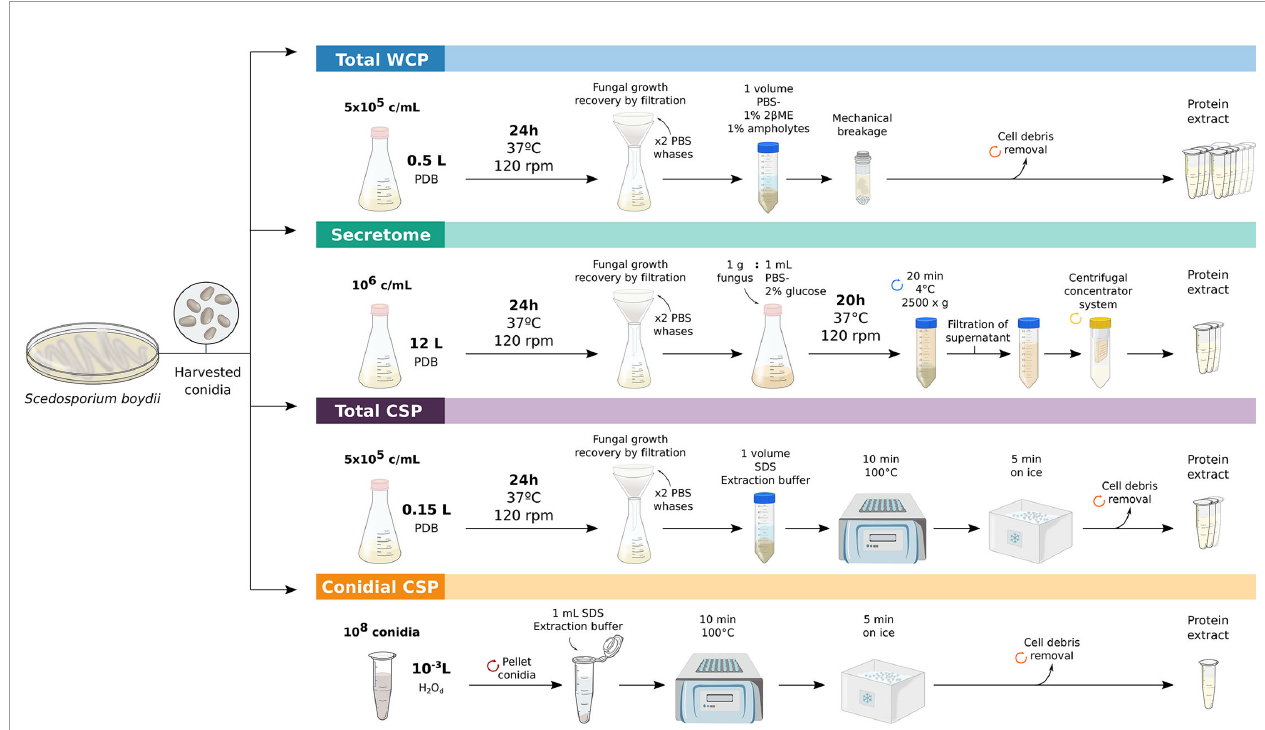
FIGURE 1 | Work fl ows employed for obtaining S. boydii protein extracts. Key-steps in the obtaining of crude total extract (Total WCP), secretome, total extract of cell-surface associated proteins (Total CSP) and conidial cell-surface associated proteins (Conidial CSP) of S.